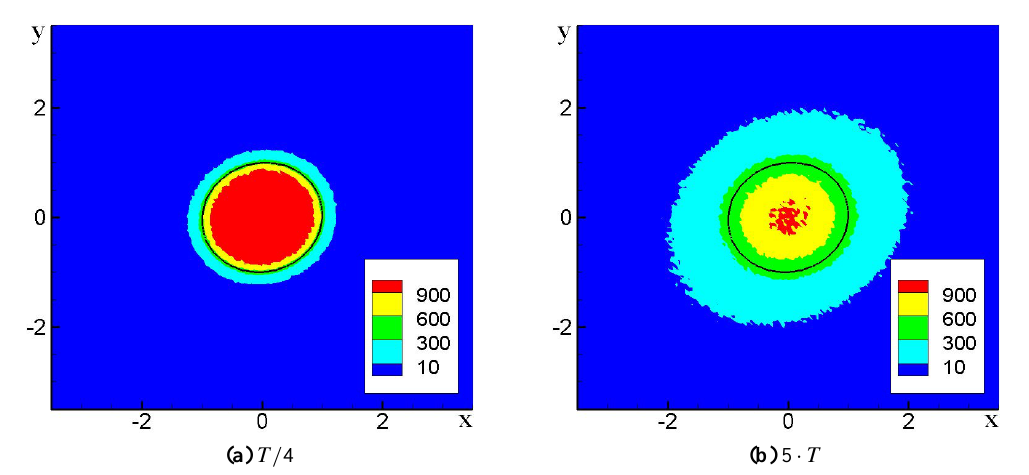
Fig. 3. Scalar concentration field at the indicated time as κ = 10 − 2 corresponding to the parameters as in Fig. 1. The bold black curve is the vortex’s boundary corresponding to the initial scalar distribution. Concentration (number of markers) is shown by colour.